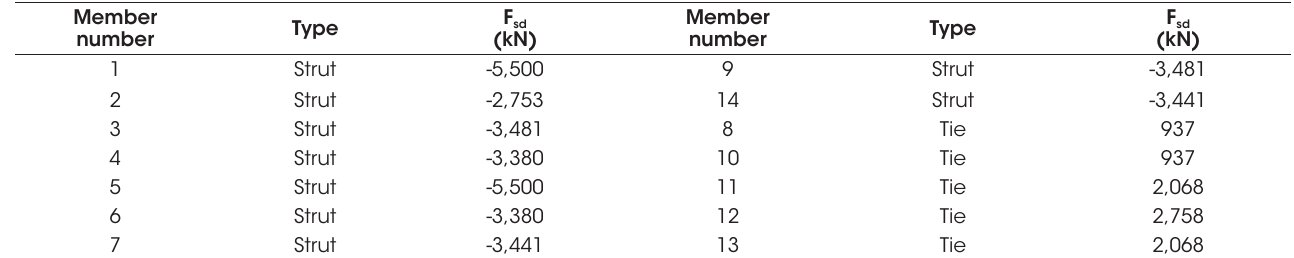
Design axial forces in the bars of the Example 2